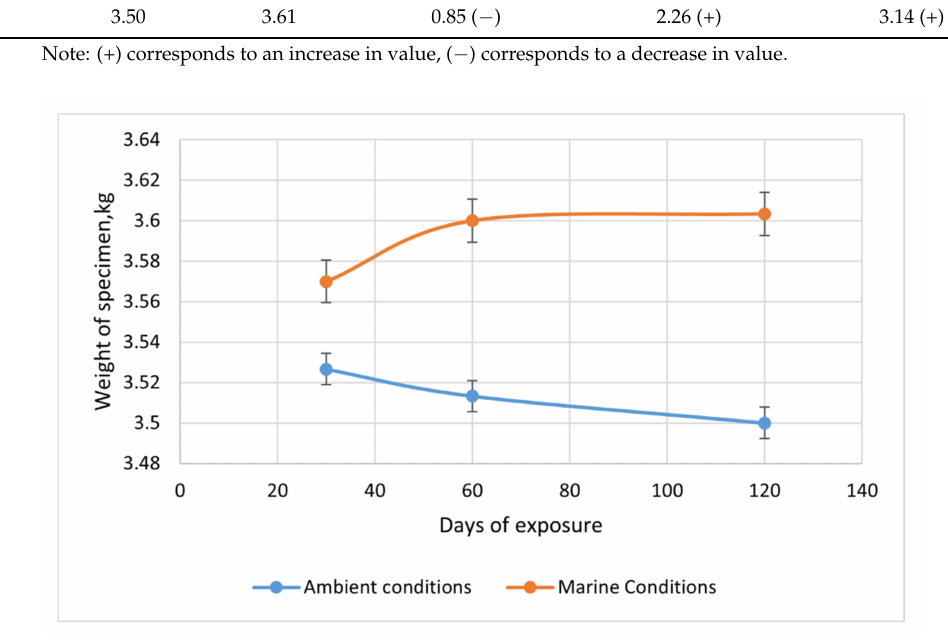
Figure 5. Weight of ambient and marine exposed